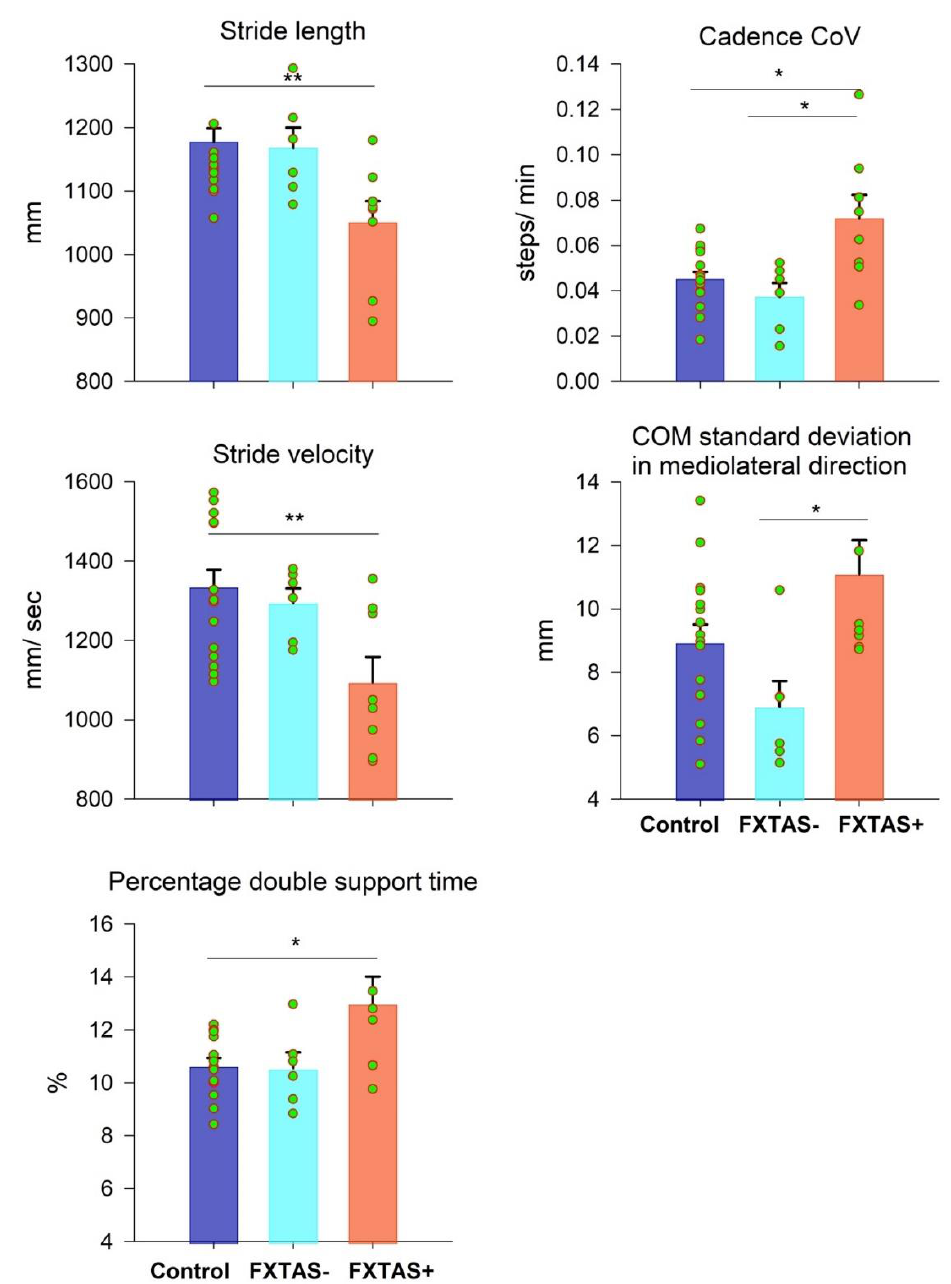
Figure 2. Mean differences in stride length, stride velocity, percentage of double support time, cadence coefficient of variation (CoV), and center of mass (COM) standard deviation in the mediolateral direction between the control (blue), FXTAS− (cyan), and FXTAS+ (orange) groups. Error bars represent standard errors. * p < 0.02. ** p < 0.01.